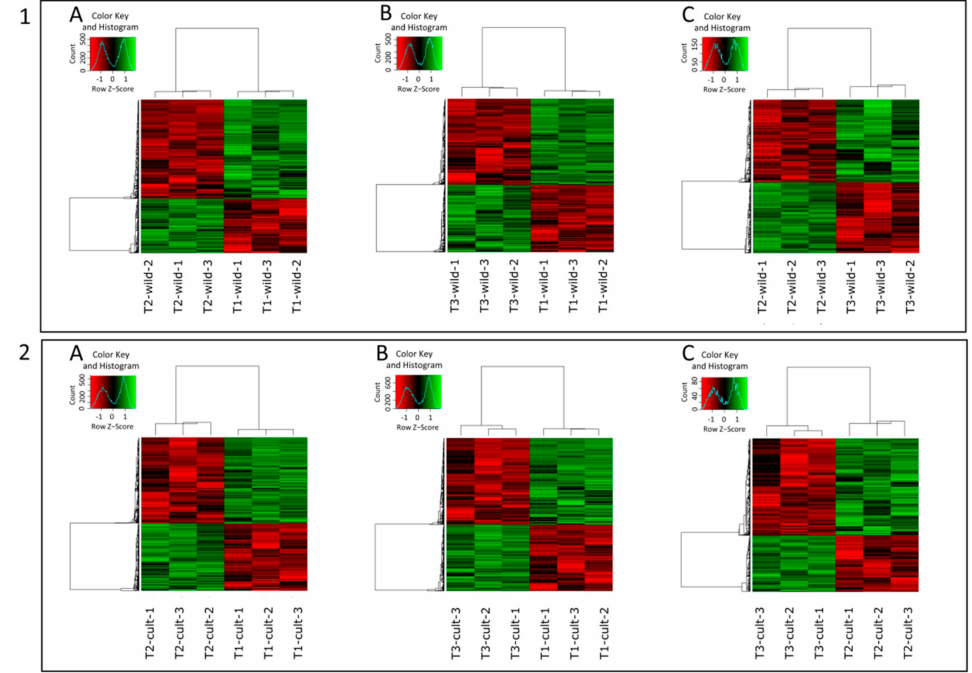
Figure 2. Heatmaps representing DEGs in wild ( 1 ) and cultivated ( 2 ) carrots for time points: T1 vs. T2